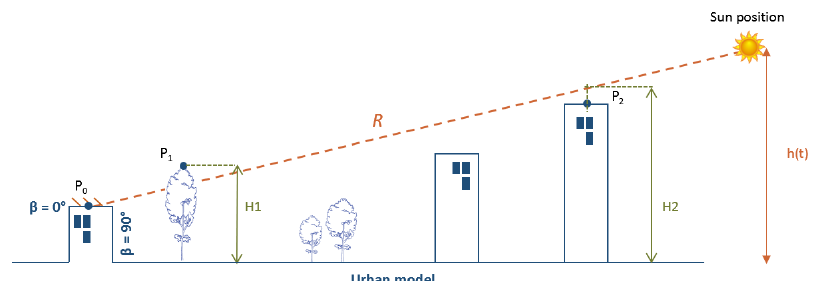
Figure 3. Shadow casting of the solar cadaster, adapted with permission from [10,14].